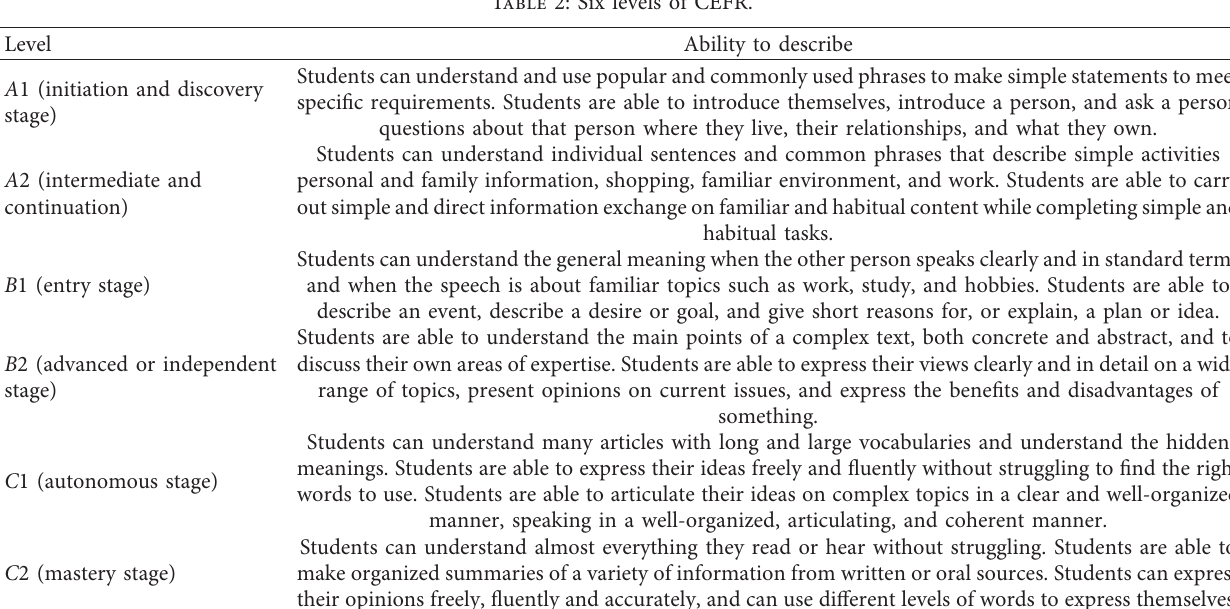
Table 2: Six levels of CEFR.